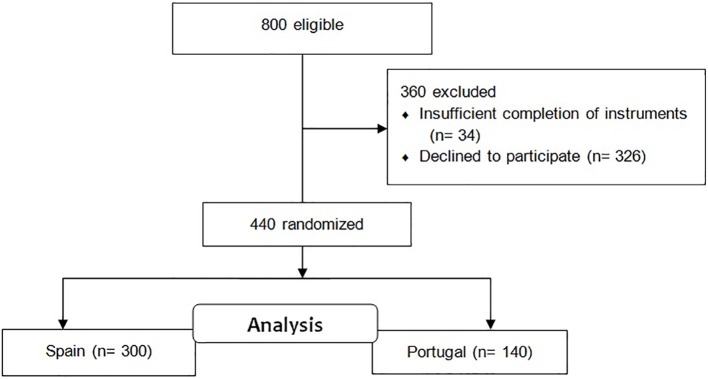
Flow diagram of recruitment of participants.